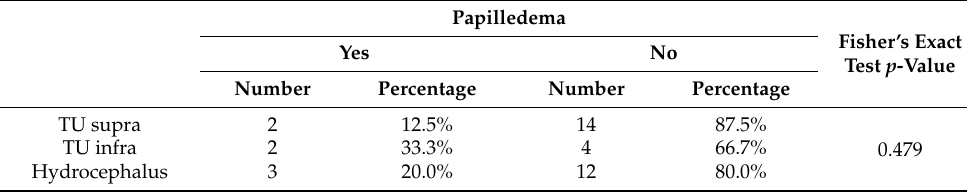
Table 3. Comparison of the presence of papilledema according to the